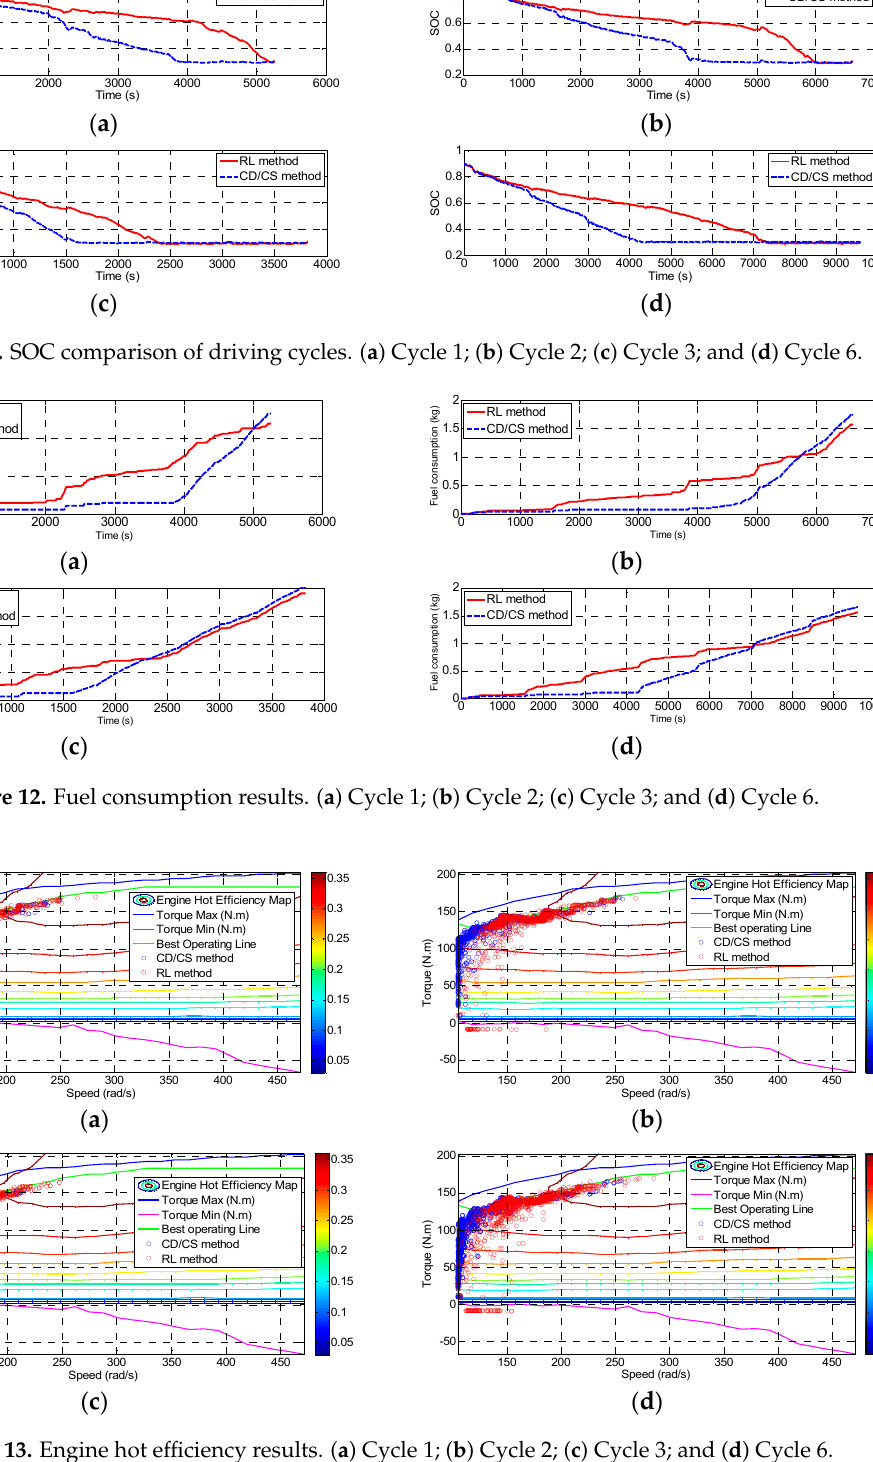
Figure 13. Engine hot efficiency results. ( a ) Cycle 1; ( b ) Cycle 2; ( c ) Cycle 3; and ( d ) Cycle 6.